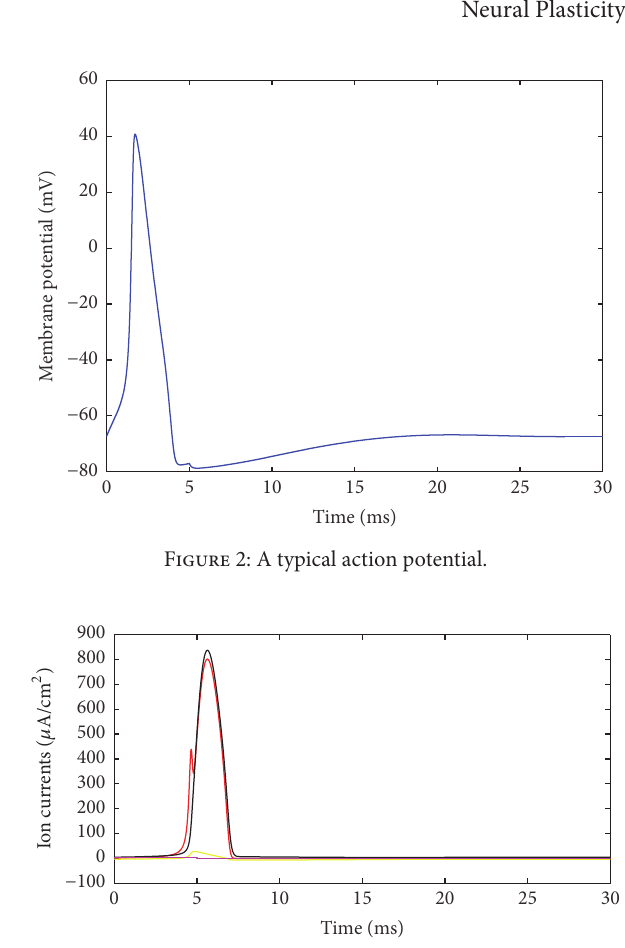
Figure 3: Different ion currents during action